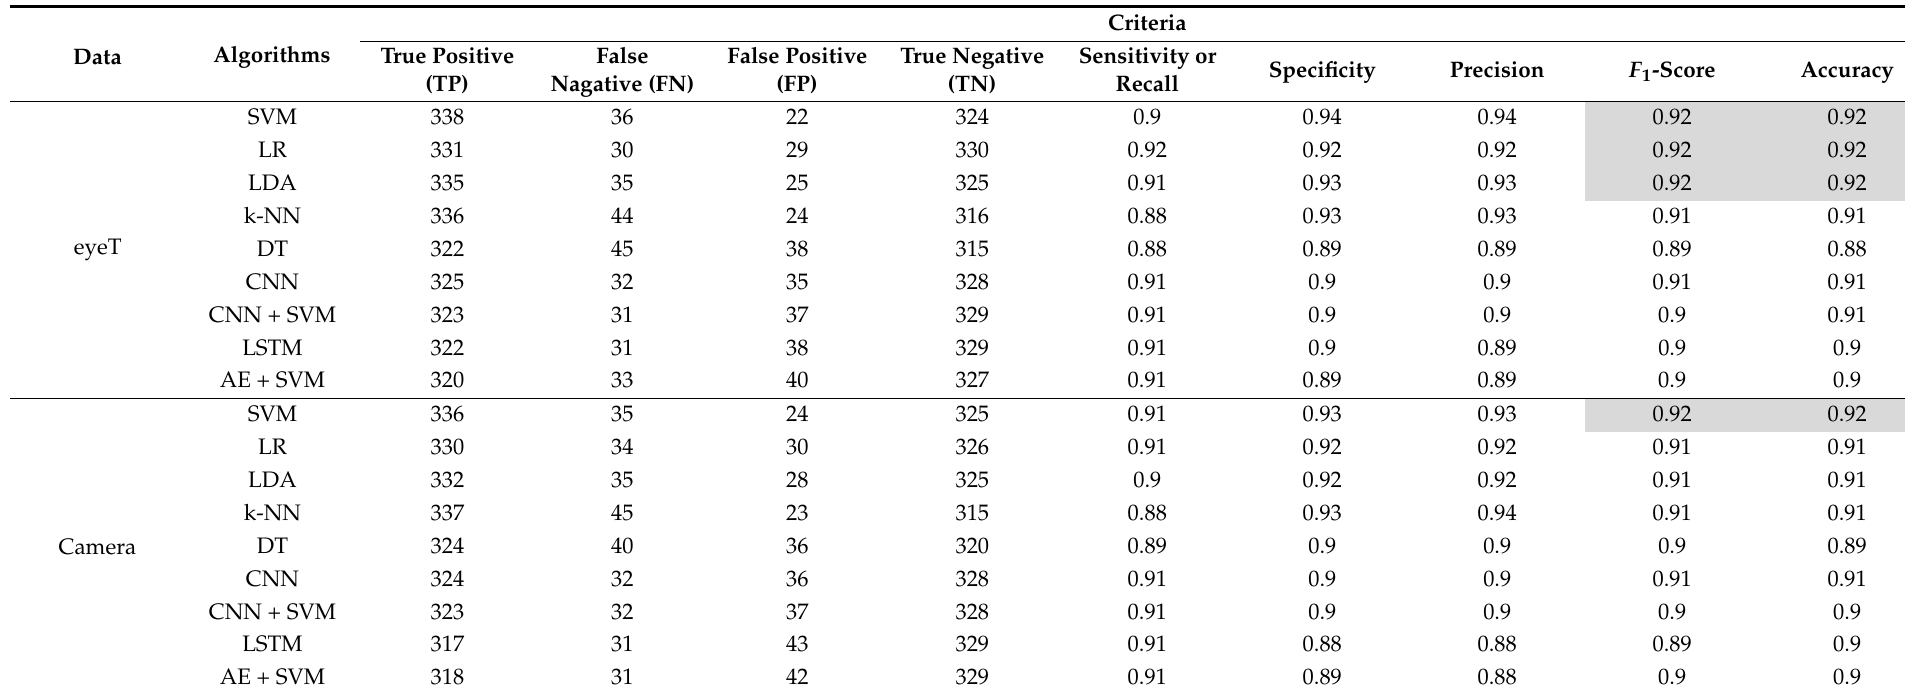
Table 5. Sensitivity, specificity, precision, F 1 -score, and accuracy for svm, lr, lda, k-nn, and dt classifiers for both eyet and camera data, where total observation is 720, 0-back classes are 360 and 1-back classes are